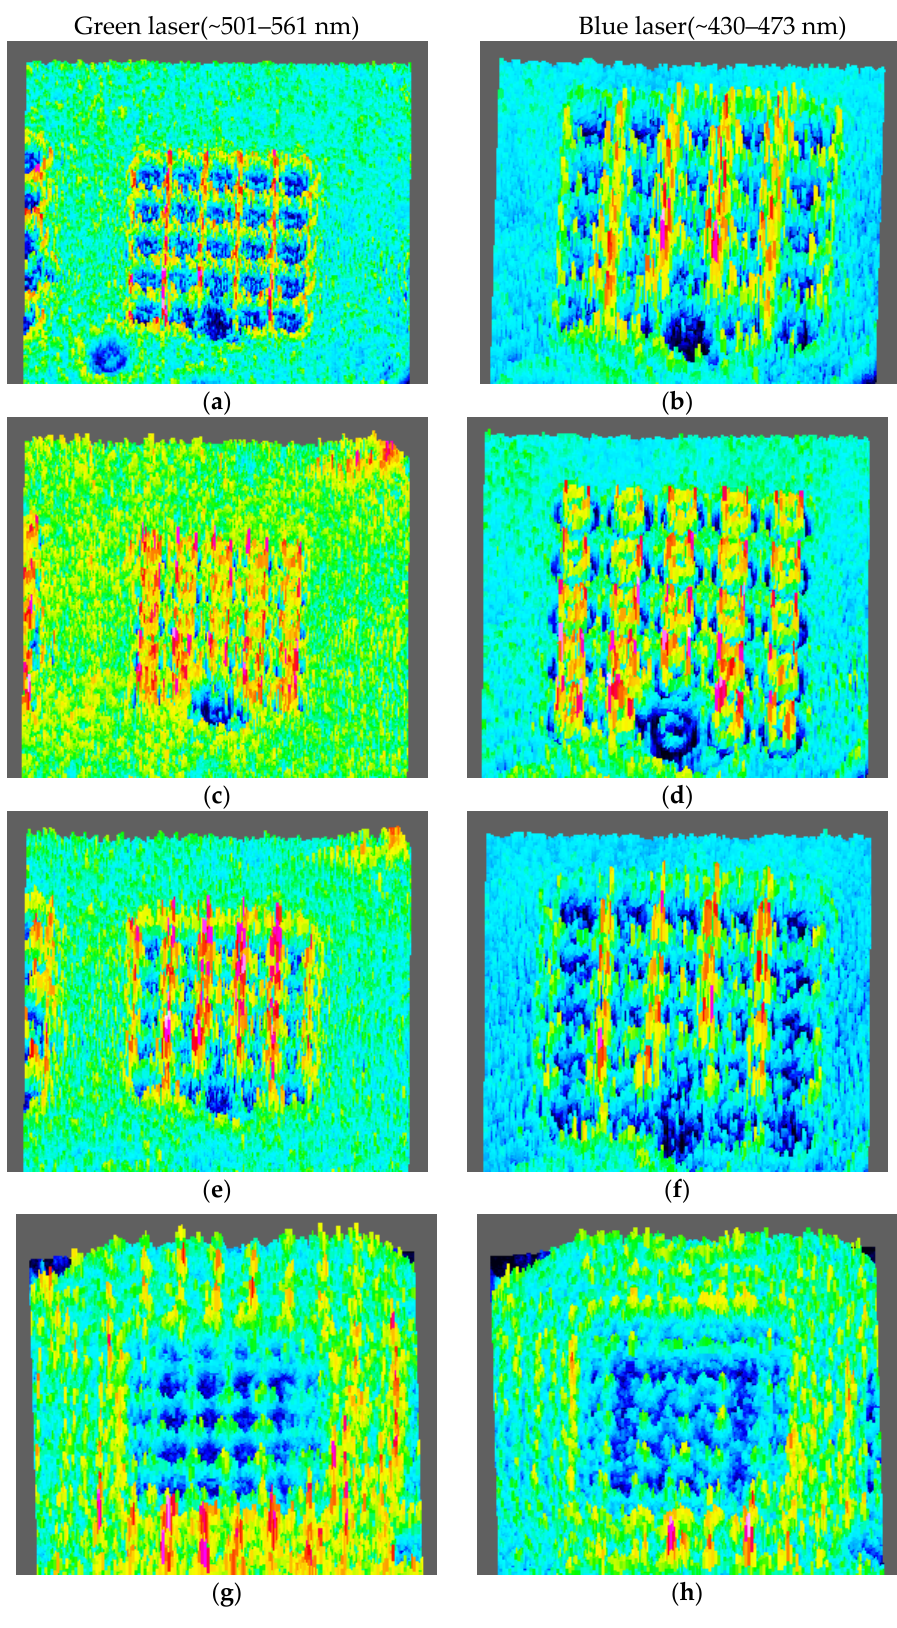
Figure 13. The three-dimension light intensity distribution of the laser beams with a center wavelength in the range of 501–561 nm, when the distance is: ( a ) 300 μ m, ( c ) 390 μ m, ( e ) 450 μ m, and ( g ) 3000 μ m, respectively. The light intensity distribution of the laser beam with a center wavelength in the range of 430–473 nm, when the distance is: ( b ) 300 μ m, ( d ) 380 μ m, ( f ) 440 μ m, and ( h ) 3000 μ m, respectively.